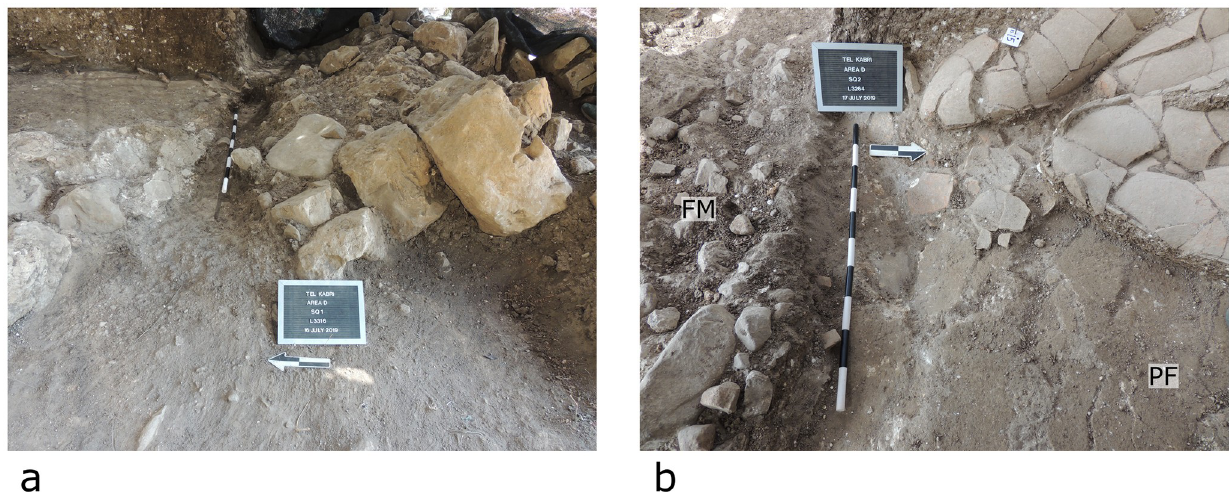
Fig 5. Field photos of collapse into the trench. (a) Photo looking northeast showing the collapse of Wall W2466 into the trench, which is now blocked by it. Arrow indicates north. (b) Photo from above in Room 3306 of the Northern Storage Complex. Left side of the image shows the trench. Right side of image shows pithoi that appear to have rolled southwards towards the trench and the collapse of the plaster floor into this feature. Arrow points to north. Each section of the scale-sticks corresponds to 10